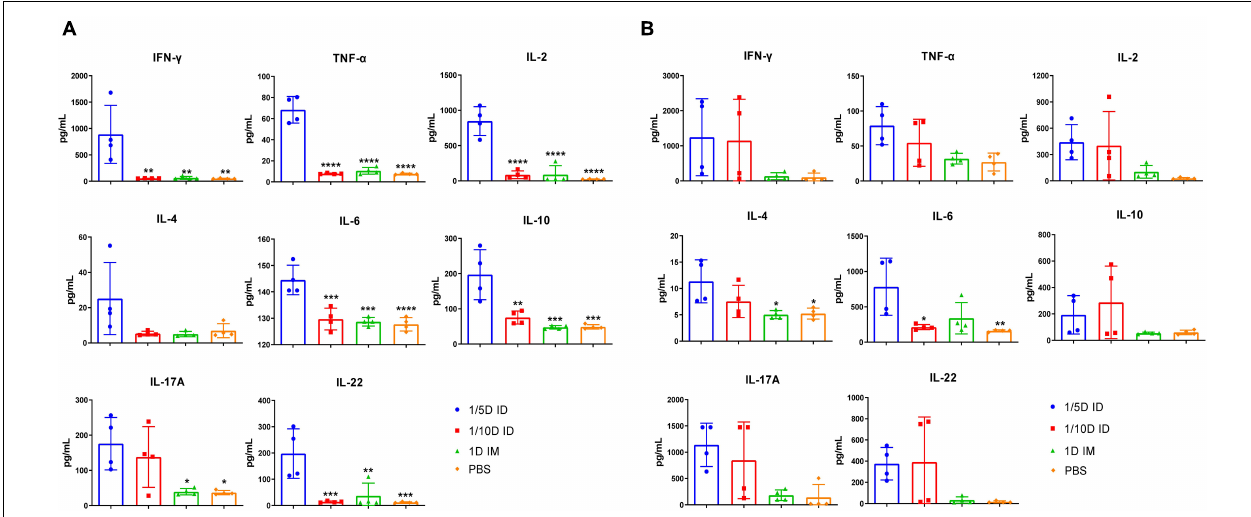
FIGURE 6 | Th1/Th17-related cytokines have increased significantly after intradermal immunization. Four weeks after the last immunization, (A) spleen and (B) lung lymphocytes were isolated. Cells were cultured at a concentration of 2 × 10 6 /ml at 37 ◦ C with 5% CO2 and stimulated with the antigens PT (1 µ g/ml), FHA (1 µ g/ml), and PRN (1 µ g/ml). Later, the supernatant was collected and detected the content of multiple cytokines in the supernatant by ELISA method, and reflects the type of immune response indirectly, where IL-2, IFN- γ , TNF- α corresponds to Th1 cell response; IL-17A, IL-22, IL-6 corresponds to Th17 cell response; IL-4, IL-10 represents Th2 cell response and inflammatory inhibition response, respectively. Results shown as pg/mL of the mean ± SEM. Data were analyzed using an one-way ANOVA model with Tukey’s multiple comparisons test. * P < 0.05, ** P < 0.01, *** P < 0.001, and **** P < 0.0001 vs 1/5D ID group ( n =